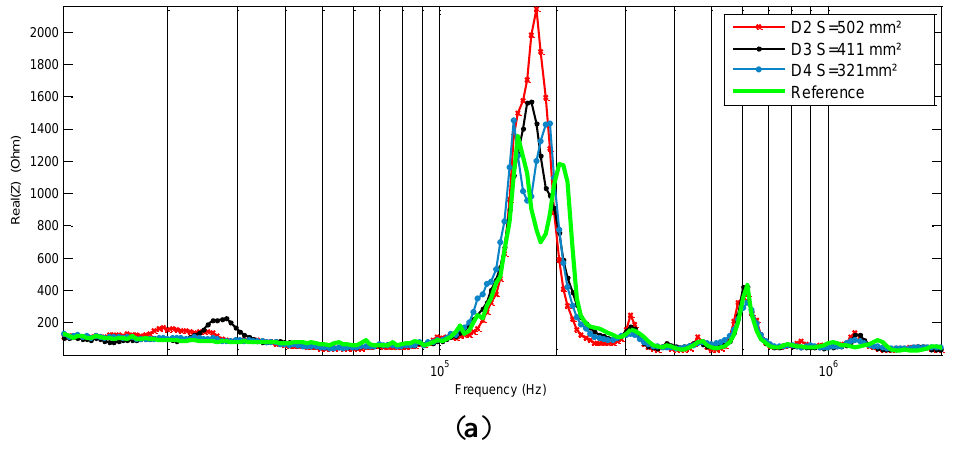
Figure 9. ( a ) Real part of the impedance measurement for each sensor. ( b ) Zoom onto lower frequencies [10 kHz–100 kHz]. ( c ) Zoom onto the sensors resonance frequency [100 kHz–300